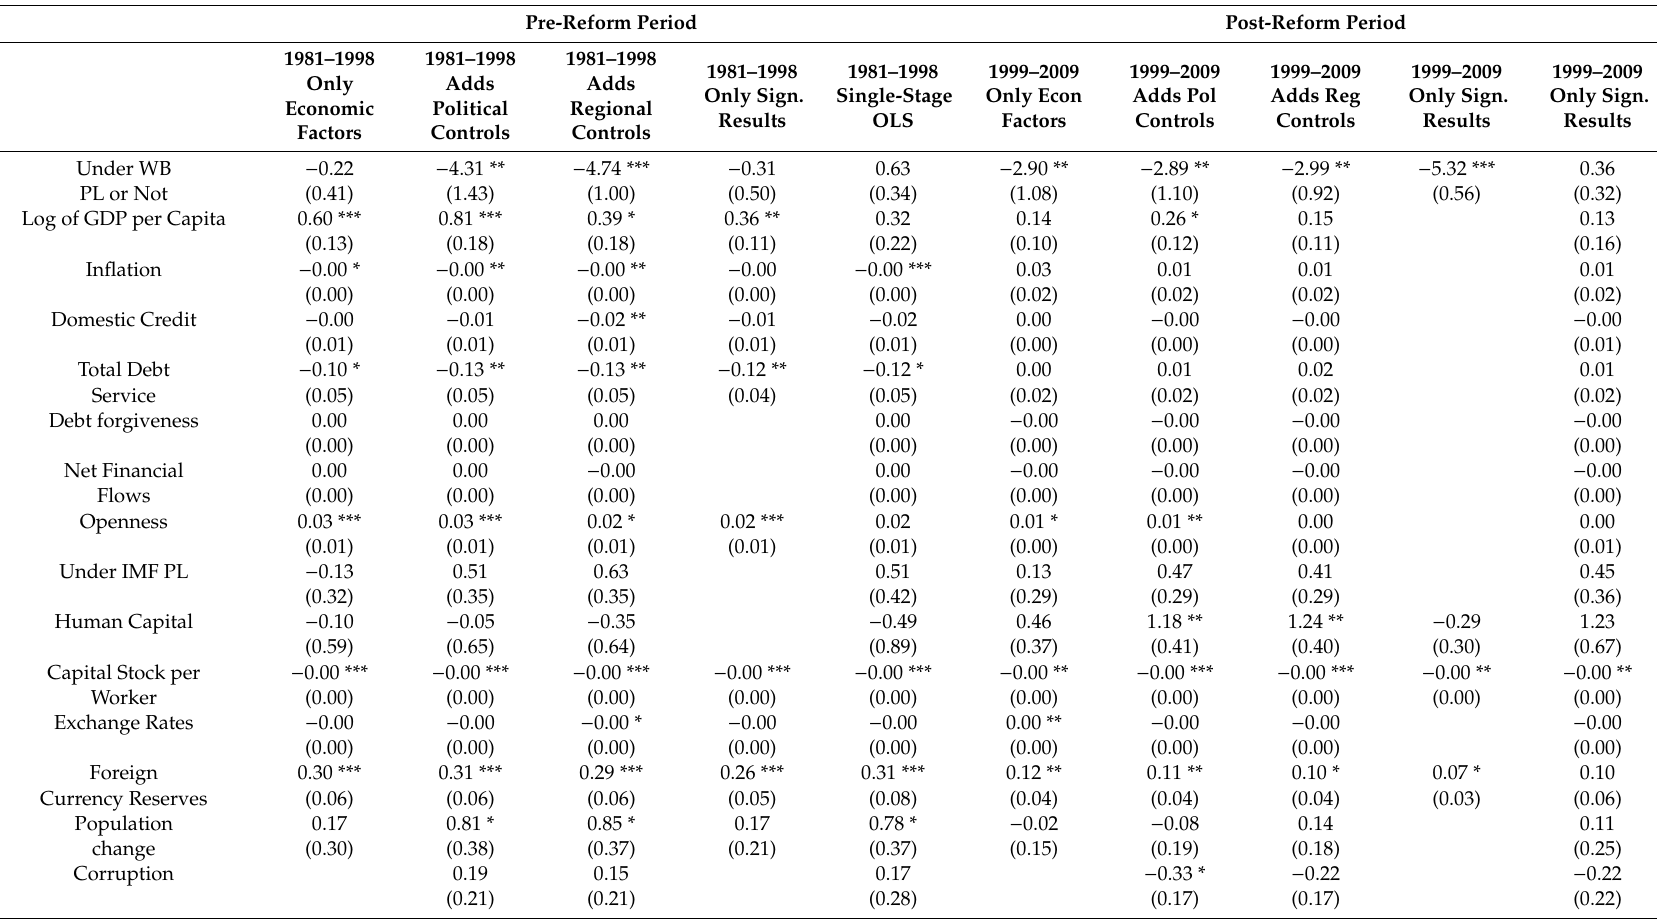
Table A4. Treatment Regression and Single-Stage OLS: World Bank Program Lending and Its E ff ects on Economic Growth, Pre-and Post-Reform Periods, All Developing Countries with Regional and Annual Fixed E ff